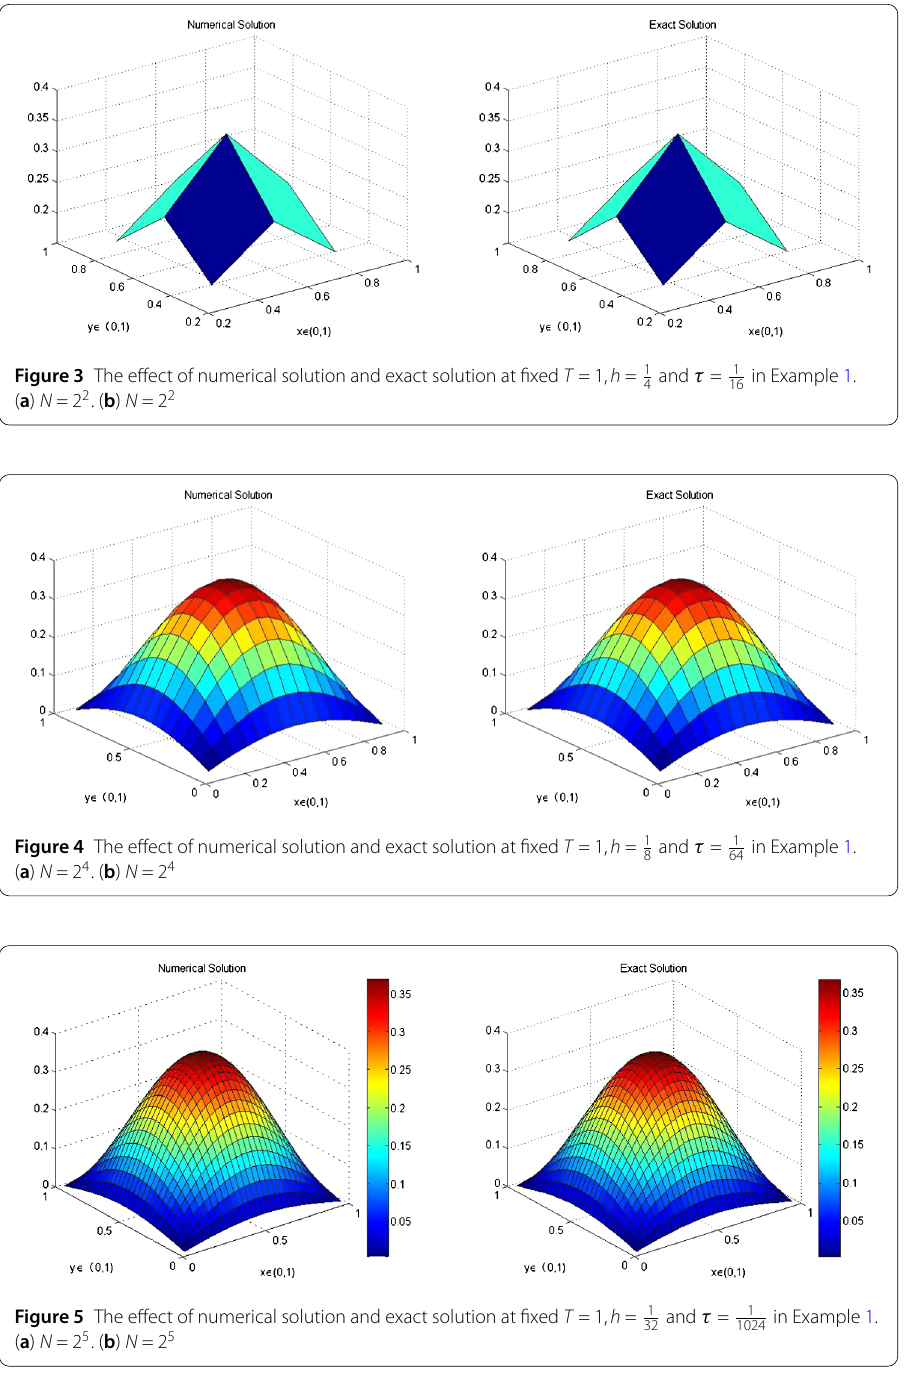
and τ = 1 in Example 1. 32 1024